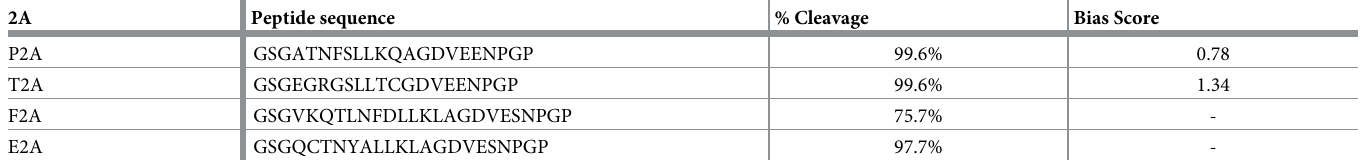
Table 1. Peptide sequences of 2A viral peptides, along with mean percent cleavage and mean bias score toward expression of the protein ordered first in the coding sequence as measured in this